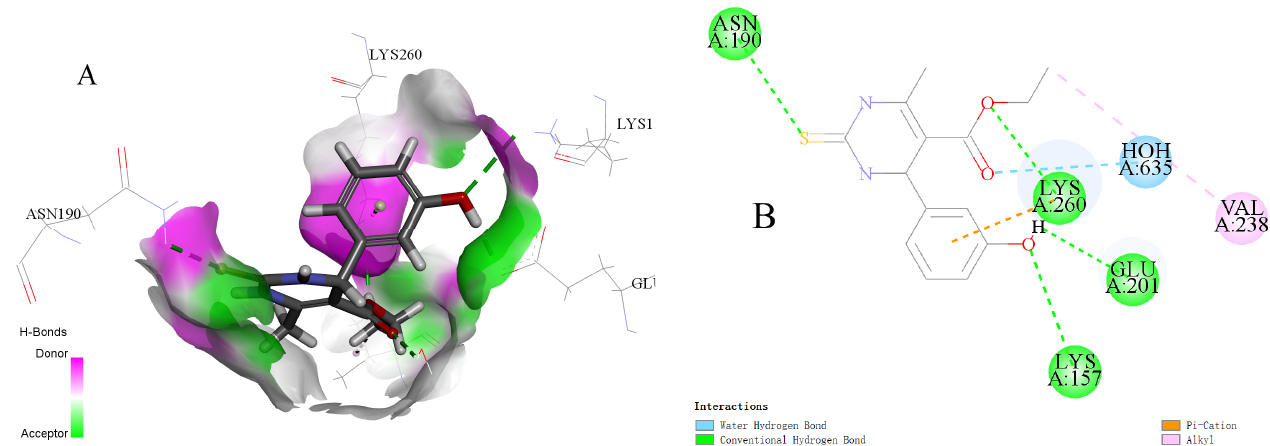
Molecules 2021 , 26 , x FOR PEER REVIEW 5 of 11 (●). Lines represent a curve fit of the global data set to a mixed-type inhibition model. ( B ) Second- ary plots of the Lineweaver–Burk plot, slope versus various concentration of C9 , with Ki = 15.73 μM. 2.3. Cytotoxity of MTS Assay Compounds C9 , D1 , D4 , D7 , D10 and D14 showed superior growth inhibition of the Caco-2 cell compared to monastrol (IC 50 = 111.62 μM), with IC 50 in a range of 65.8–107.57 μM. Moreover, C9 , D1 , D3 and D10 showed growth inhibition of the Hela cell line with